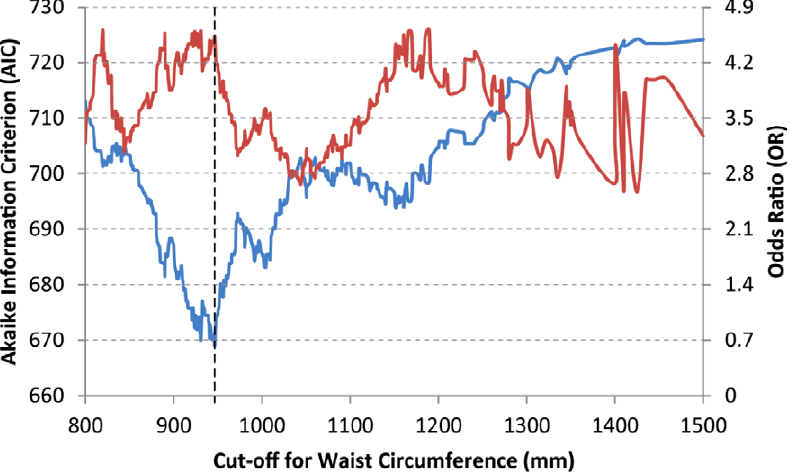
Figure 1. Determination of the optimal cut-point for waist circumference as a predictor of cumulative T2D risk. Figure shows Akaike information criterion (left y-axis) and odds ratio (right y-axis) for a cut-point of waist circumference indicated on the x-axis. Dashed vertical line indicates the optimal cut-point. doi:10.1371/journal.pone.0059153.g001 PLOS ONE |